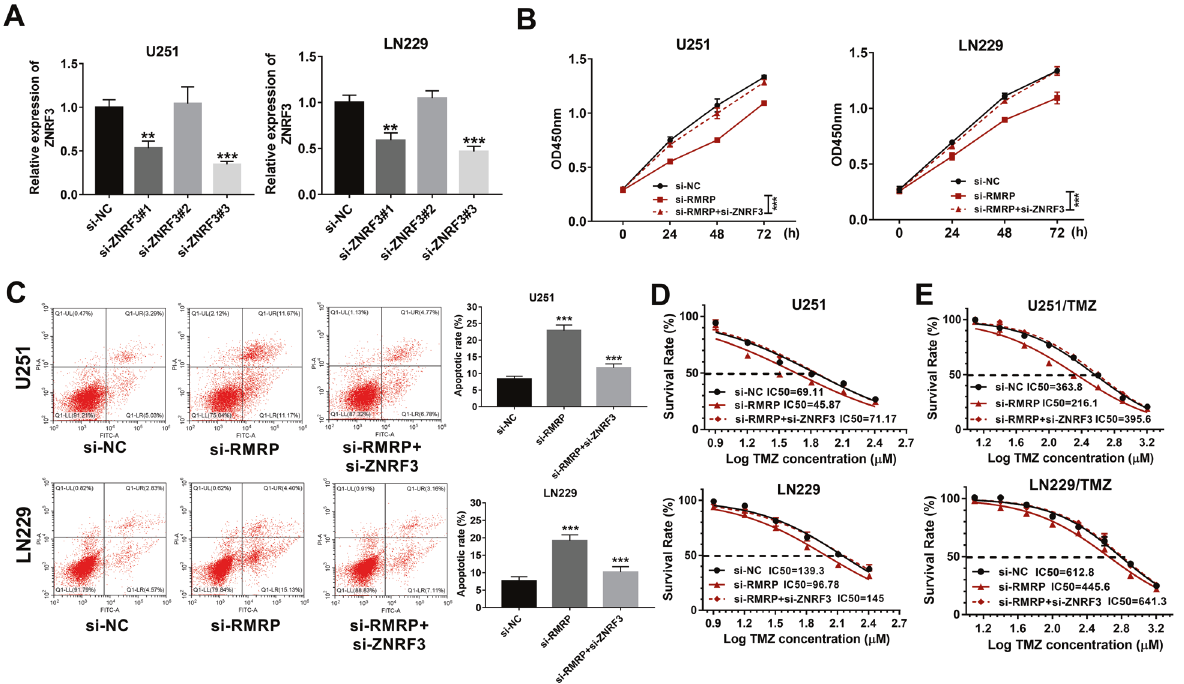
Fig. 5 ZNRF3 down-regulation weakened the effects of RMRP knockdown on glioma cell proliferation, apoptosis, and TMZ resistance. A Knockdown ef fi ciency analysis of si-ZNRF3#1, si-ZNRF3#2, or si-ZNRF3#3 in U251 and LN229 cells by RT-qPCR assay at 48 h post-transfection ( n = 3). B – D U251 and LN229 cells were transfected with si-NC, si-RMRP, or si-RMRP + si-ZNRF3, followed by the measurement of cell proliferative ability B ( n = 3), cell apoptotic rate C ( n = 3), and TMZ IC 50 values D ( n = 3). E TMZ IC 50 values were determined by CCK-8 assay in U251/TMZ and LN229/TMZ cells treated with different doses of TMZ ( n = 3). ** P < 0.01. *** P <